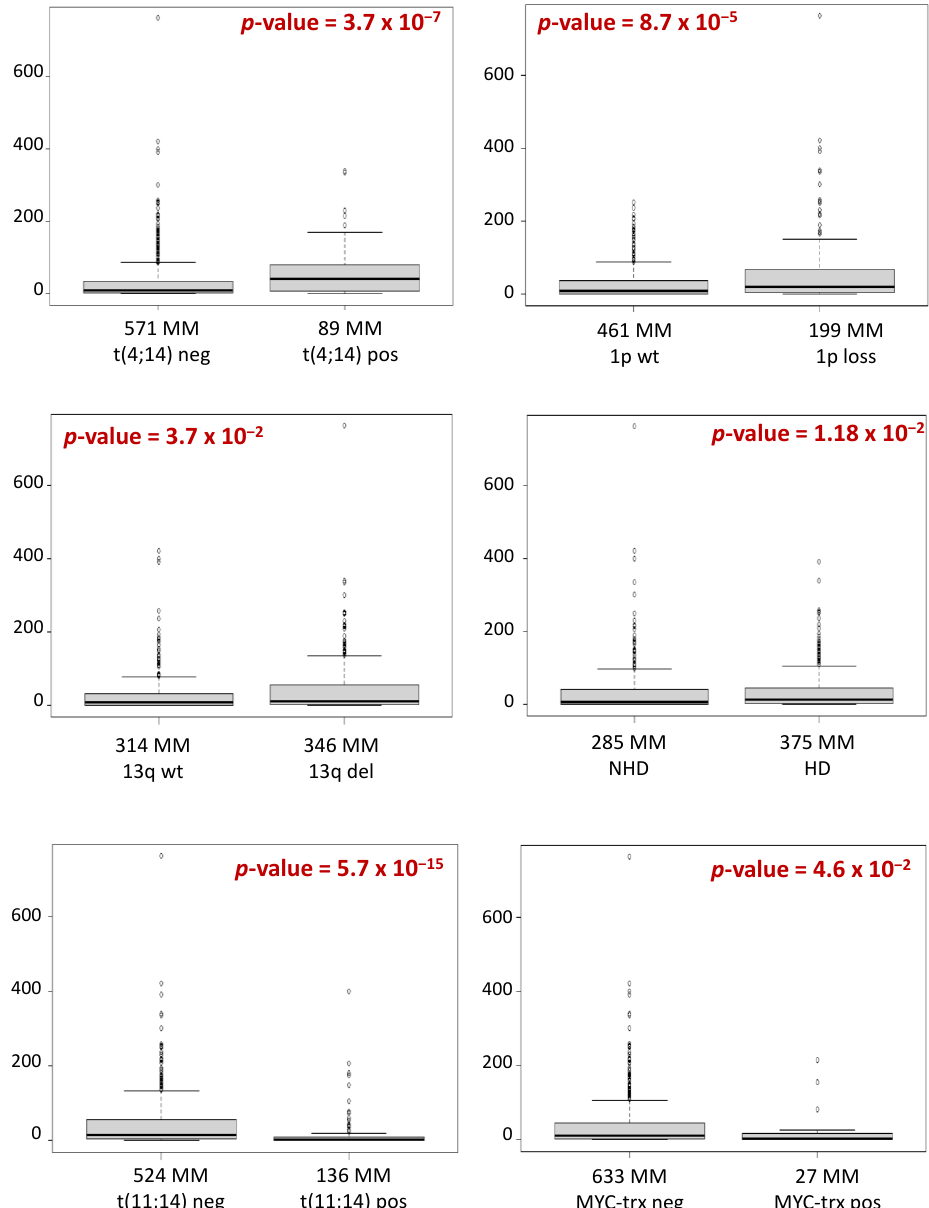
Figure 1. Box plots of MIAT expression level in 660 MM cases stratified according to the presence of t(4;14), del(1p), del(13q), hyperdiploidy (HD), t(11;14) or MYC translocations (MYC-trx). Differential expression was tested by Wilcoxon rank-sum test with continuity correction. p -values were corrected by BH adjustment.